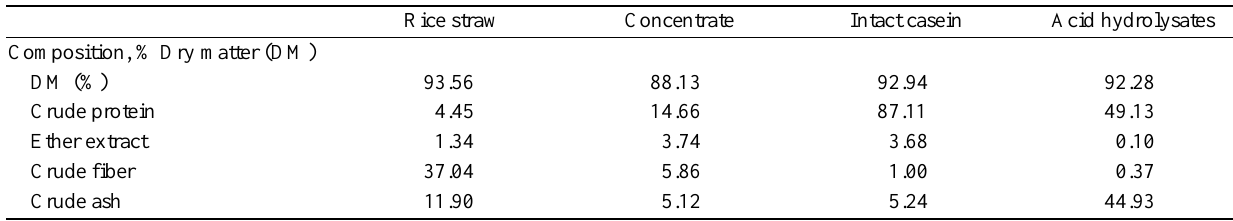
The water and vitamin and mineral block were available at all times. Table 2. Intake of dietary ingredients Item Dry matter intake (DMI, kg/d)